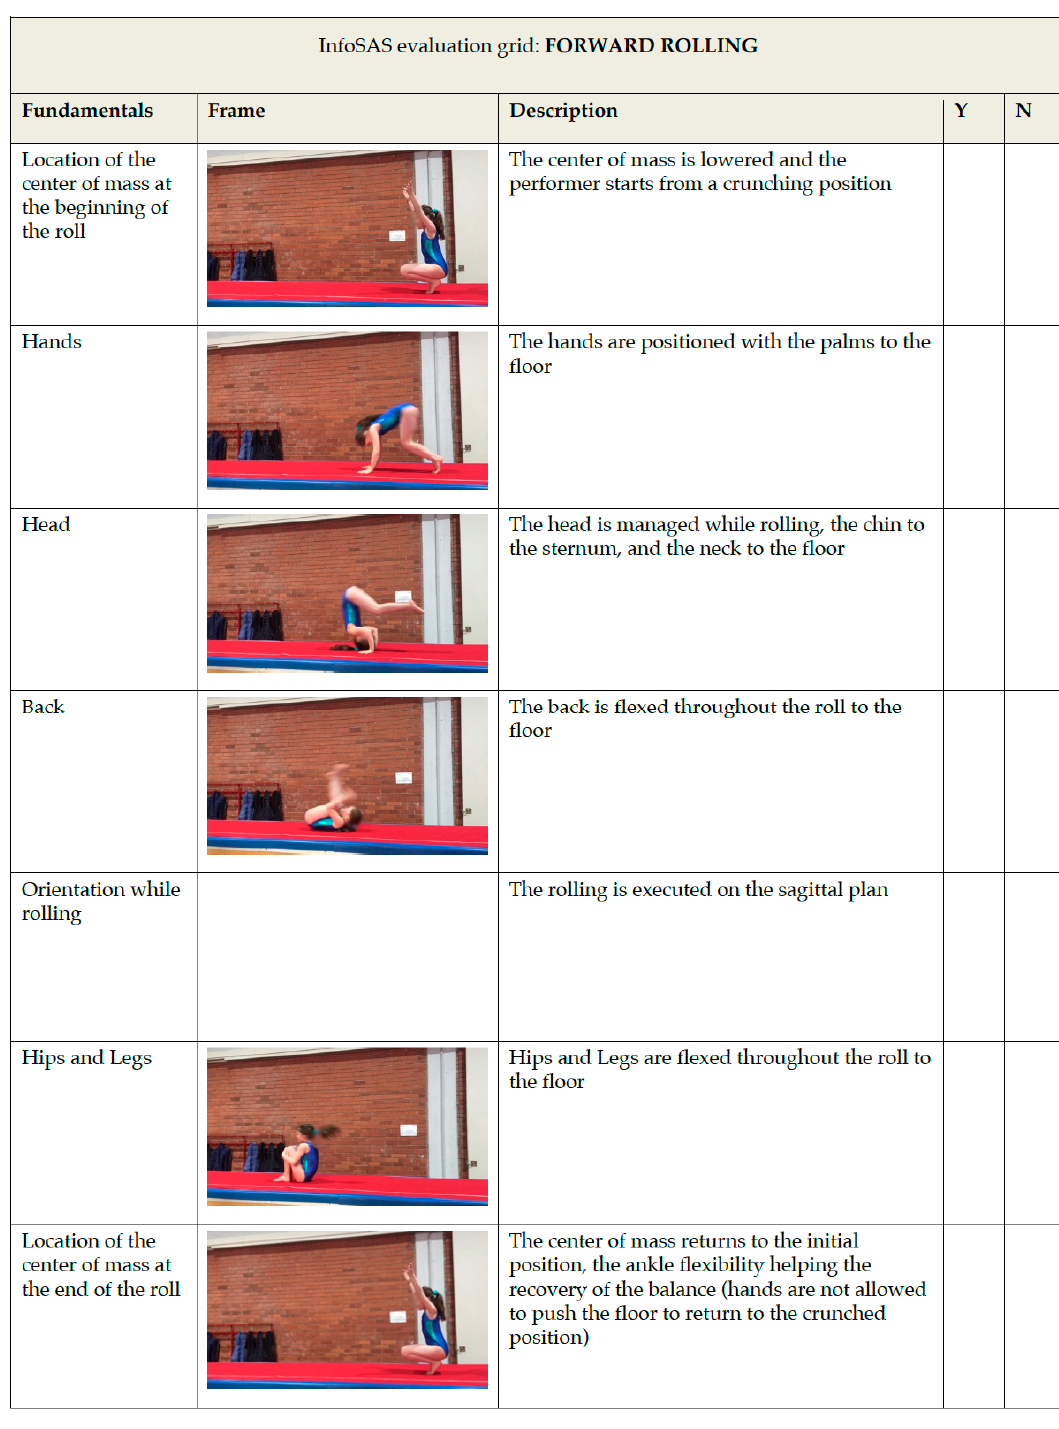
Figure A3. InfoSAS evaluation grid for forward rolling rating.